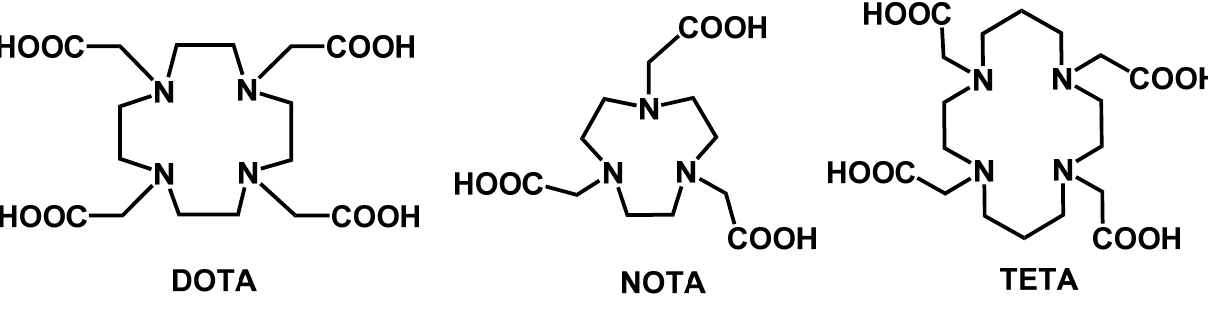
Figure 8. Macrocyclic bifunctional chelating agents: DOTA, NOTA and